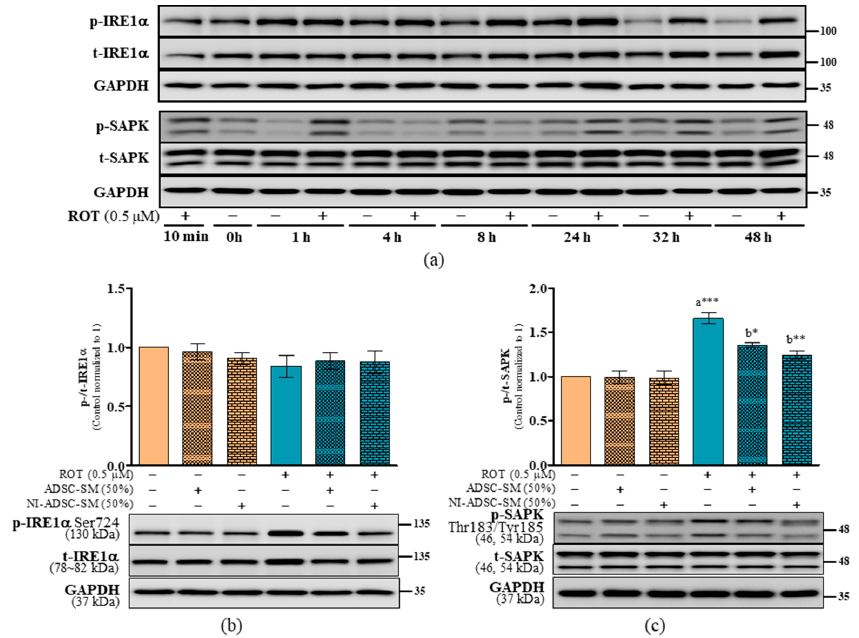
Figure 9. Effects of the NI-ADSC-SM on IRE1 α and SAPK/JNK expression. Cells treated with or without ROT (0.5 µ M) at different timepoints were assessed for IRE1 α and SAPK by Western